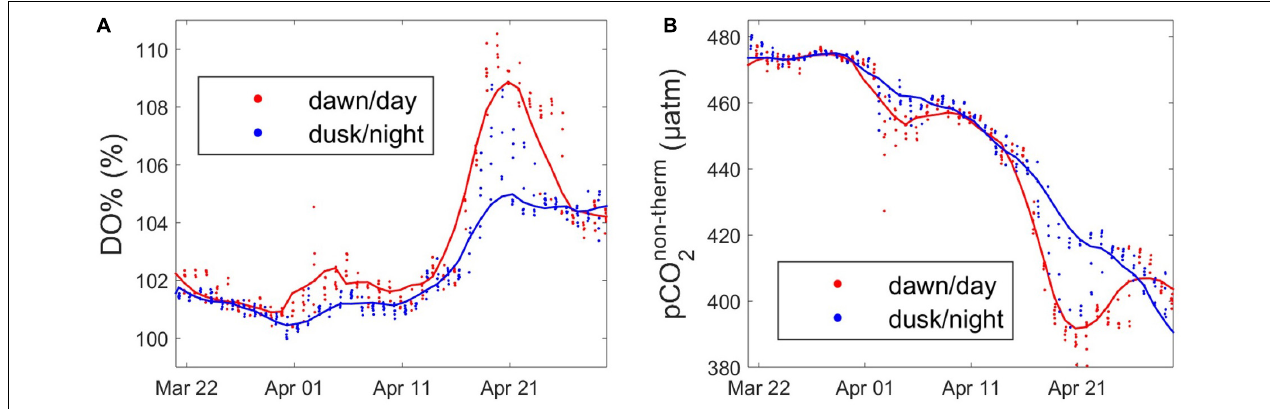
FIGURE 7 | Diurnal variability of (A) DO% (%) and (B) pCO 2 non − therm ( µ atm) data extracted at dawn (red) and dusk (blue) ± 3 h during the productive period, from 22/03/2016 to 27/04/2016. Smooth lines in blue and red are obtained using a moving average filter with a 5-data span on the corresponding